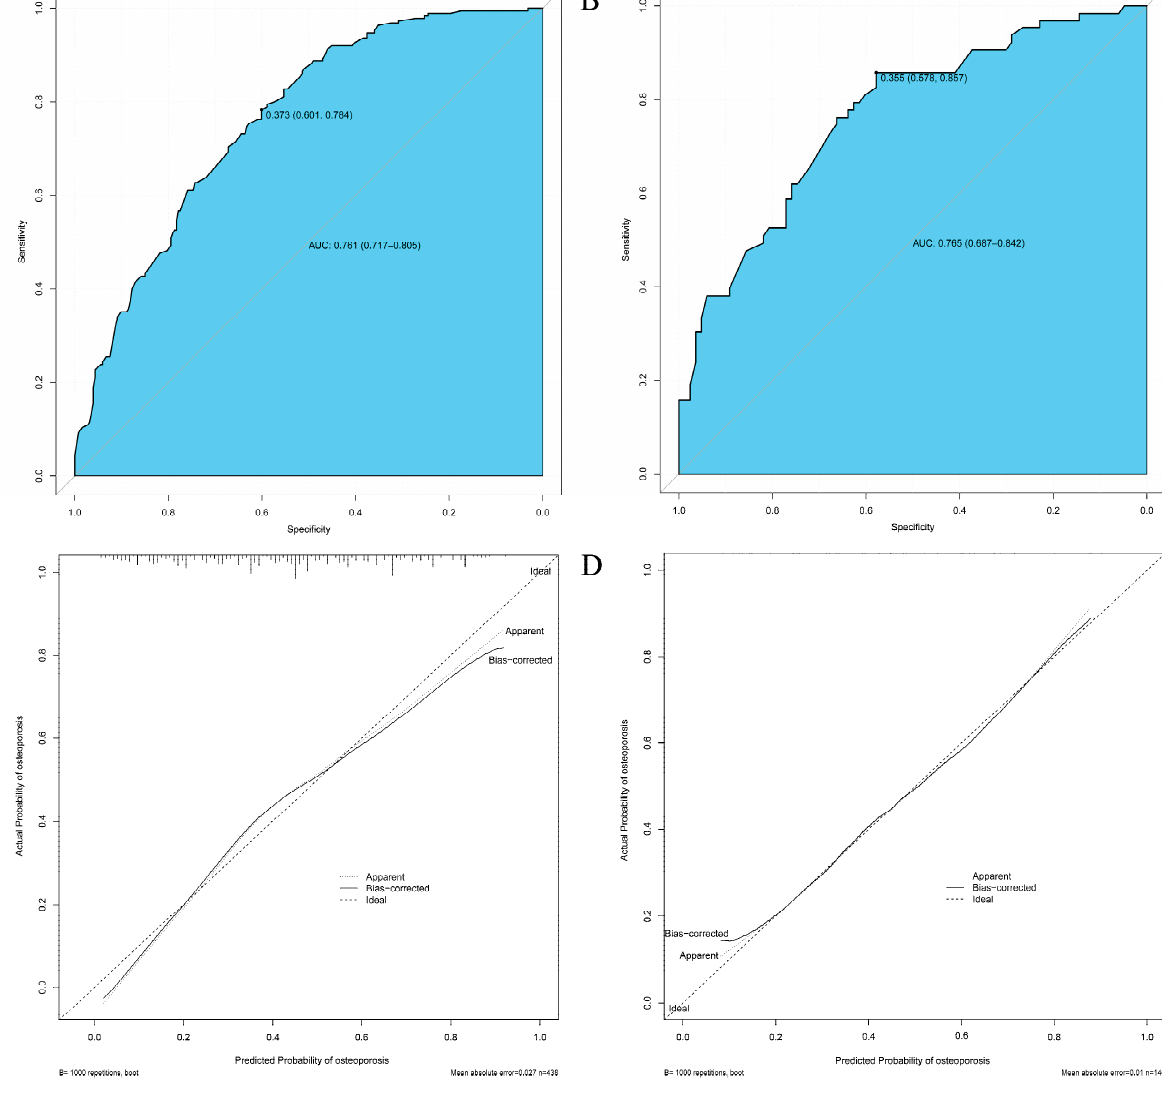
Figure 5. Validation of discrimination and calibration of nomogram prediction models. ( A ) ROC curve of the training group; ( B ) ROC curve of the validation group; ( A , B ) ROC, AUC, 95% CI, and cutoff values were shown. Higher AUC values suggested higher discrimination of the nomogram clinical prediction model. ( C ) Calibration curve of the training group; ( D ) Calibration curve of the validation group. ( C , D ) The horizontal coordinate was the probability of predicted osteoporosis based on the nomogram clinical prediction model. The vertical coordinate was the actual probability of osteoporosis. The Ideal line was the diagonal dashed line, representing the predicted probability equal to the actual probability under the optimal condition. The Apparent line and the Bias-corrected line, respectively, represent the predicted probability and the actual probability of the nomogram clinical prediction model developed in this study under the present real conditions. The closer these two lines were to the Ideal line (diagonal dashed line), the better the nomogram clinical prediction model was, and the better its calibration was. Abbreviations: ROC, receiver operator characteristic curve; AUC, the area under the ROC curve; CI, confidence intervals.